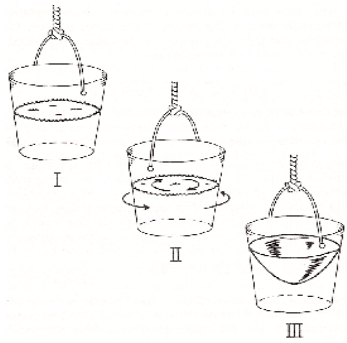
Figure 1. Newton’s bucket thought experiment.